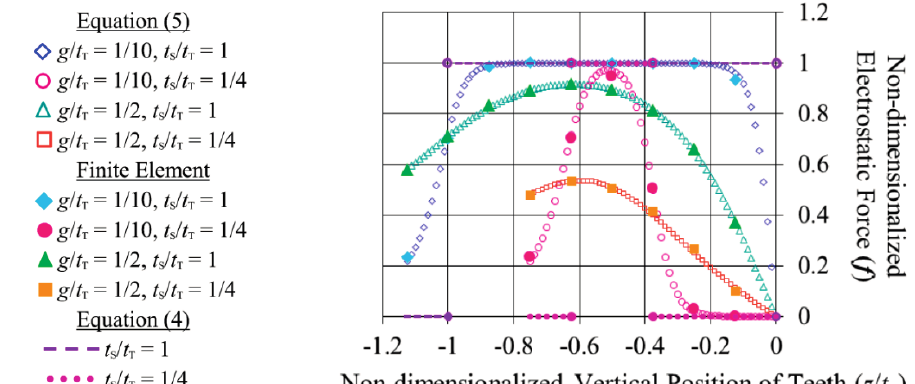
Figure 4. Different predictions of the fraction of the maximum electrostatic force that acts on the movable combs over their